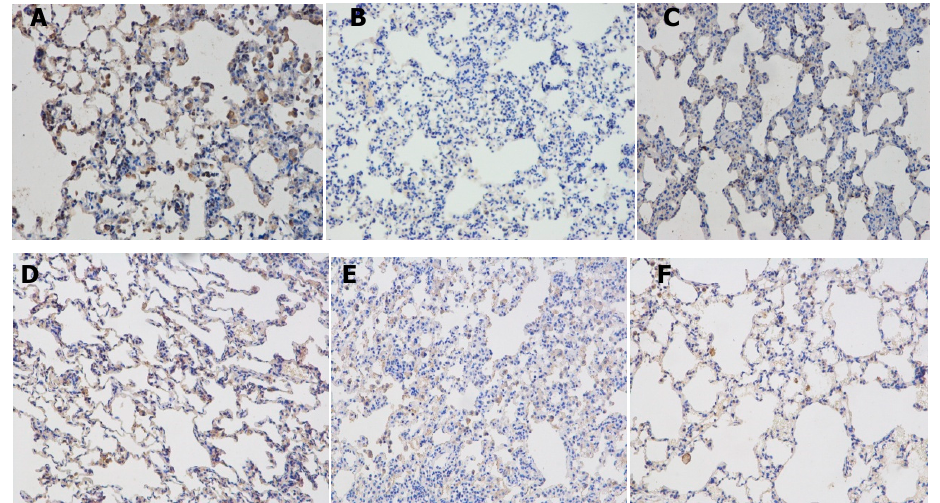
Figure 5. Expressions of SIRT1 and PGC-1 α in lung tissues in rats. ( A ) Expression of SIRT1 in lung tissues in the control group; (n = 10) ( B ) SIRT1 protein in the lung in the COPD group; (n = 10) ( C ) SIRT1 protein in the lung in the resveratrol intervention group (n = 10) (Magnification, × 200) ( D ) Expression of PGC-1 α in lung tissues in the control group; (n = 10) ( E ) PGC-1 α protein in the lung in the COPD group; (n = 10) ( F ) PGC-1 α protein in the lung in the resveratrol intervention group. (n = 10) (Magnification, ×